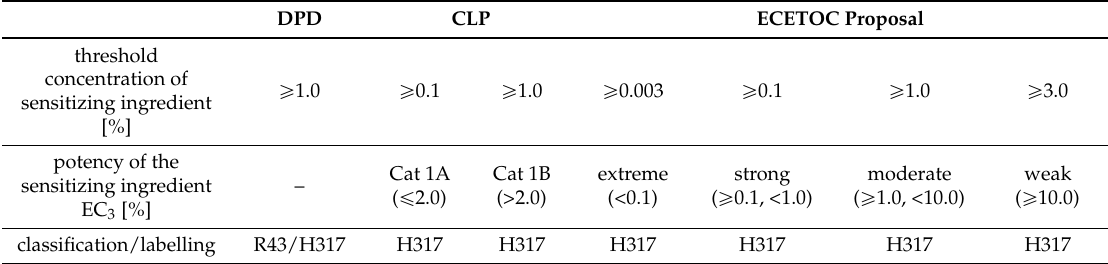
Table 1. Cut-off values of sensitizing ingredients leading to classification of a related mixture/product